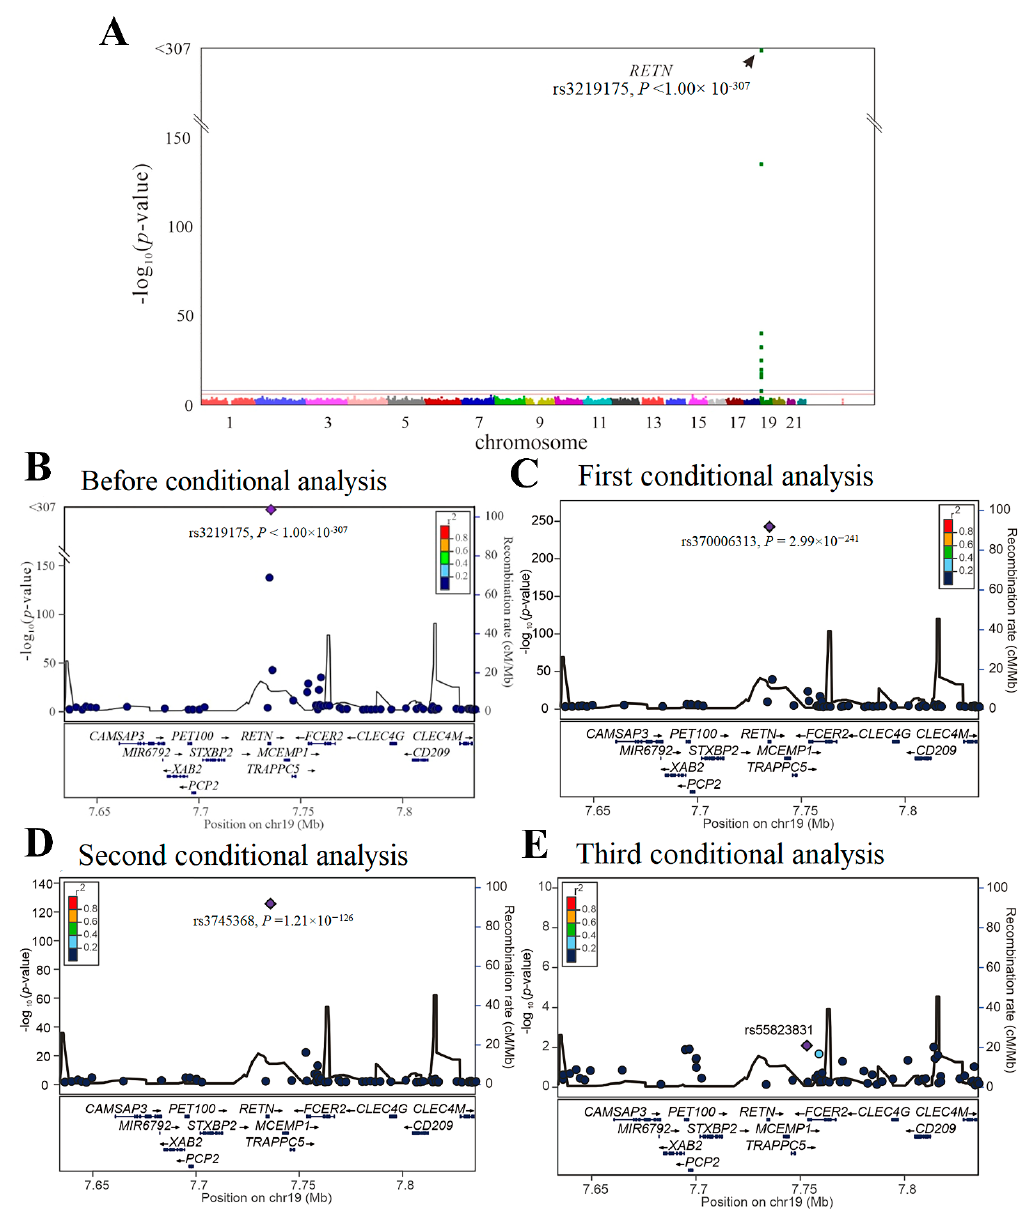
Figure 1. Conditional analysis of RETN candidate SNPs using GWAS data in the TWB cohort. ( A ) Manhattan plots for resistin levels from the genome-wide association study of 4652 Taiwan Biobank participants depict the only one peak above genome-wide significance on chromosome 19p13.2, where the RETN gene is located (arrow). ( B ) Before conditional analysis, regional association plots for resistin level surrounding the RETN locus show rs3219175 as the lead SNP. ( C ) After the first conditional analysis adjusting the rs3219175 genotypes, rs370006313 in the regional plot at the RETN locus becomes a significant association with resistin levels. ( D ) After the second conditional analysis adjusting for both rs3219175 and rs370006313 genotypes, rs3745368 is significantly associated with resistin levels. ( E ) After the third conditional analysis adjusting for the aforementioned SNPs, no more single SNP is found to be genome-wide significantly associated with resistin